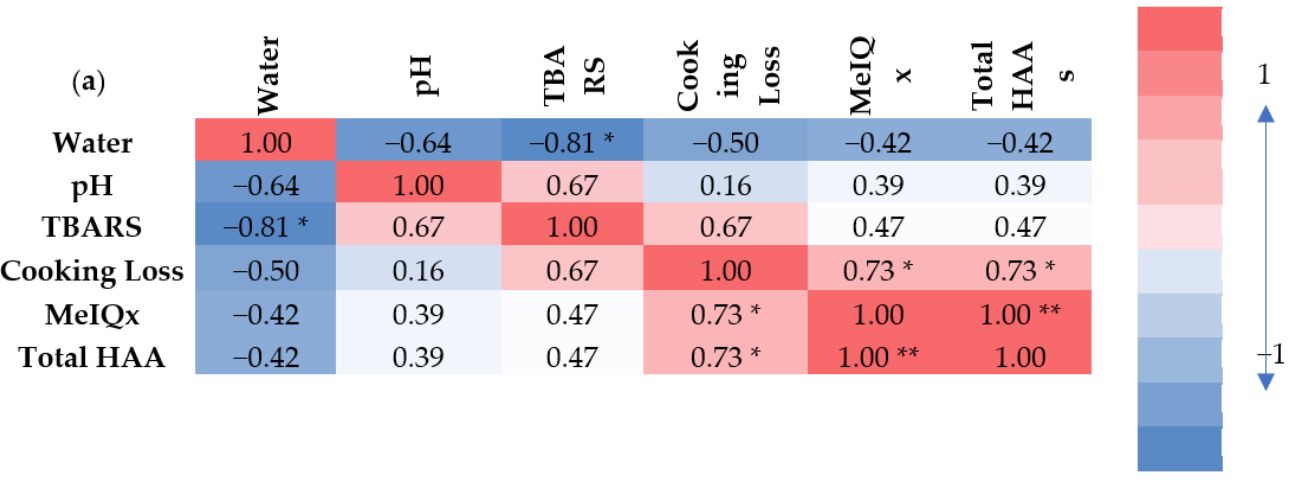
Figure 1. Correlation between water, pH, TBARS, cooking loss, and the formation of HAAs. *: p < 0.05; **: p < 0.01.